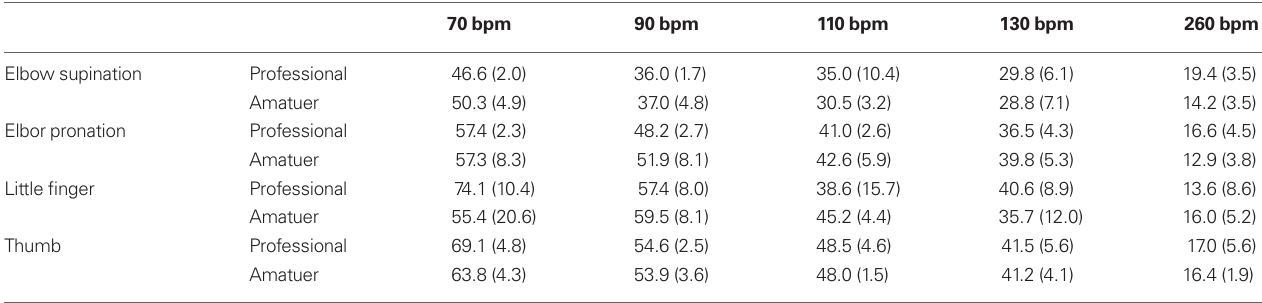
Table 3 | group means of the time at peak joint angular velocities at five striking tempi.